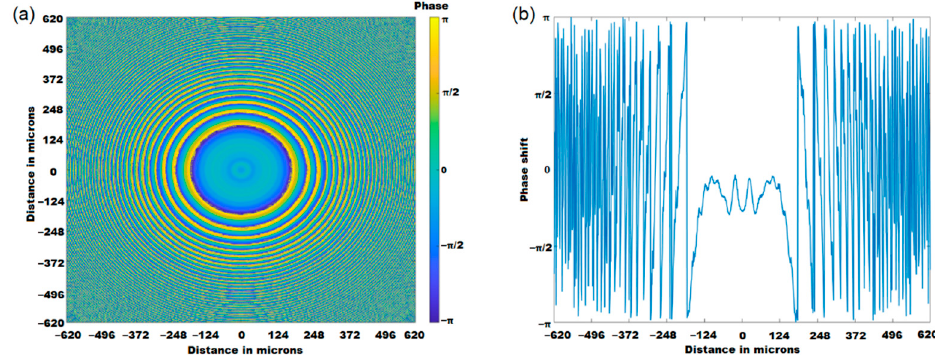
Figure 4. ( a ) The optical element and ( b ) line plot along the center of the phase element.